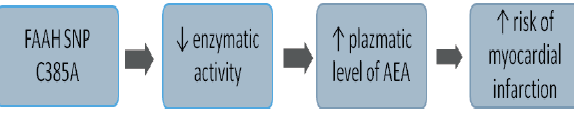
Fig. 2. Summary of the results of the study. Single nucleotide polymorphism C385A in the FAAH gene causes amino acid exchange (proline to threonine) with subsequent decrease in enzyme activity. This results in decreased degradation of anan- damide and its increased plasma levels with negative conse- quentions on vasculature (higher risk of atherosclerosis and myocardial